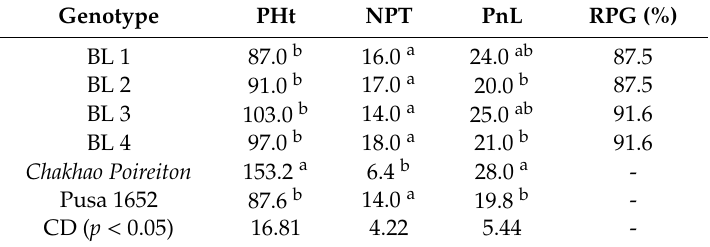
Table 2. Agronomic data of backcross-derived lines of Chakhao Poireiton / Pusa 1652 showing the height reduction and increased number of productive